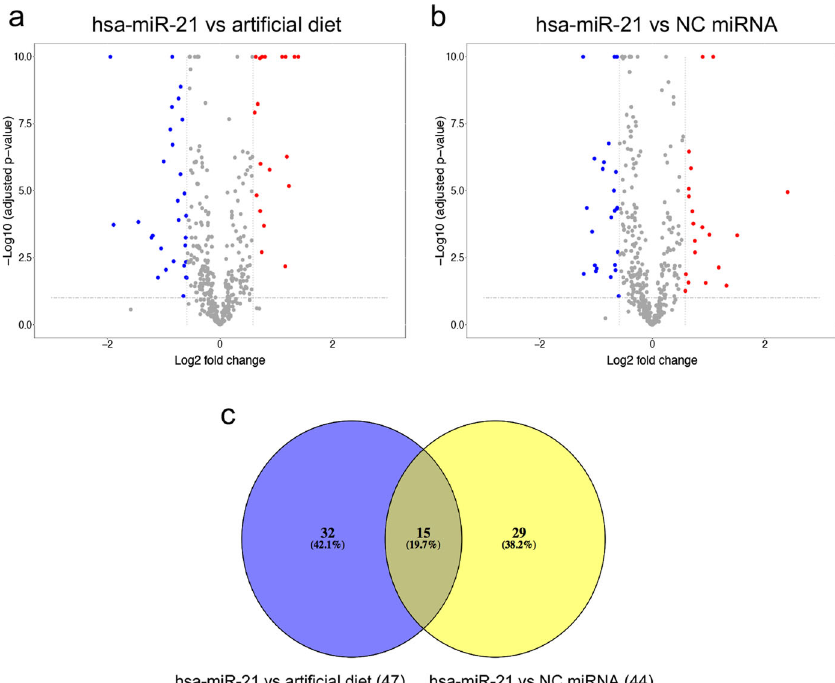
Fig. 5 hsa-miR-21-5p mimic modulates the proteome of the fat body in Ae. aegypti . Ae. aegypti mosquitoes were fed on arti fi cial diet only, an arti fi cial diet with NC mimic, or arti fi cial diet with hsa-miR-21 mimic. Fat body was dissected 12 h after feeding; proteins were extracted, processed and identi fi ed using LC-MS/MS. Quanti fi able proteins were used to determine differentially abundant proteins between a hsa-miR-21 mimic and arti fi cial diet fed mosquitoes, and b hsa-miR-21 and NC mimic fed mosquitoes. Differentially abundant proteins were considered when they had an adjusted p value <0.05 and a fold change >1.5. c A Venn diagram of differentially abundant proteins from ( a , b ) and the overlaps. Three biological replicates per treatment were used for the proteomics analysis.